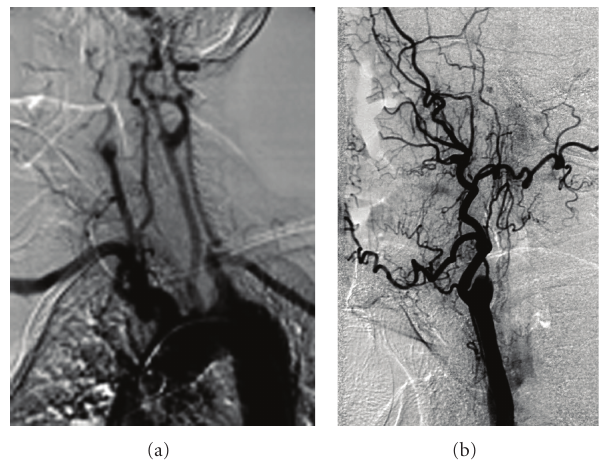
Figure 1: (a) Angiography of the aortic arch. (b) The angiography shows internal carotid